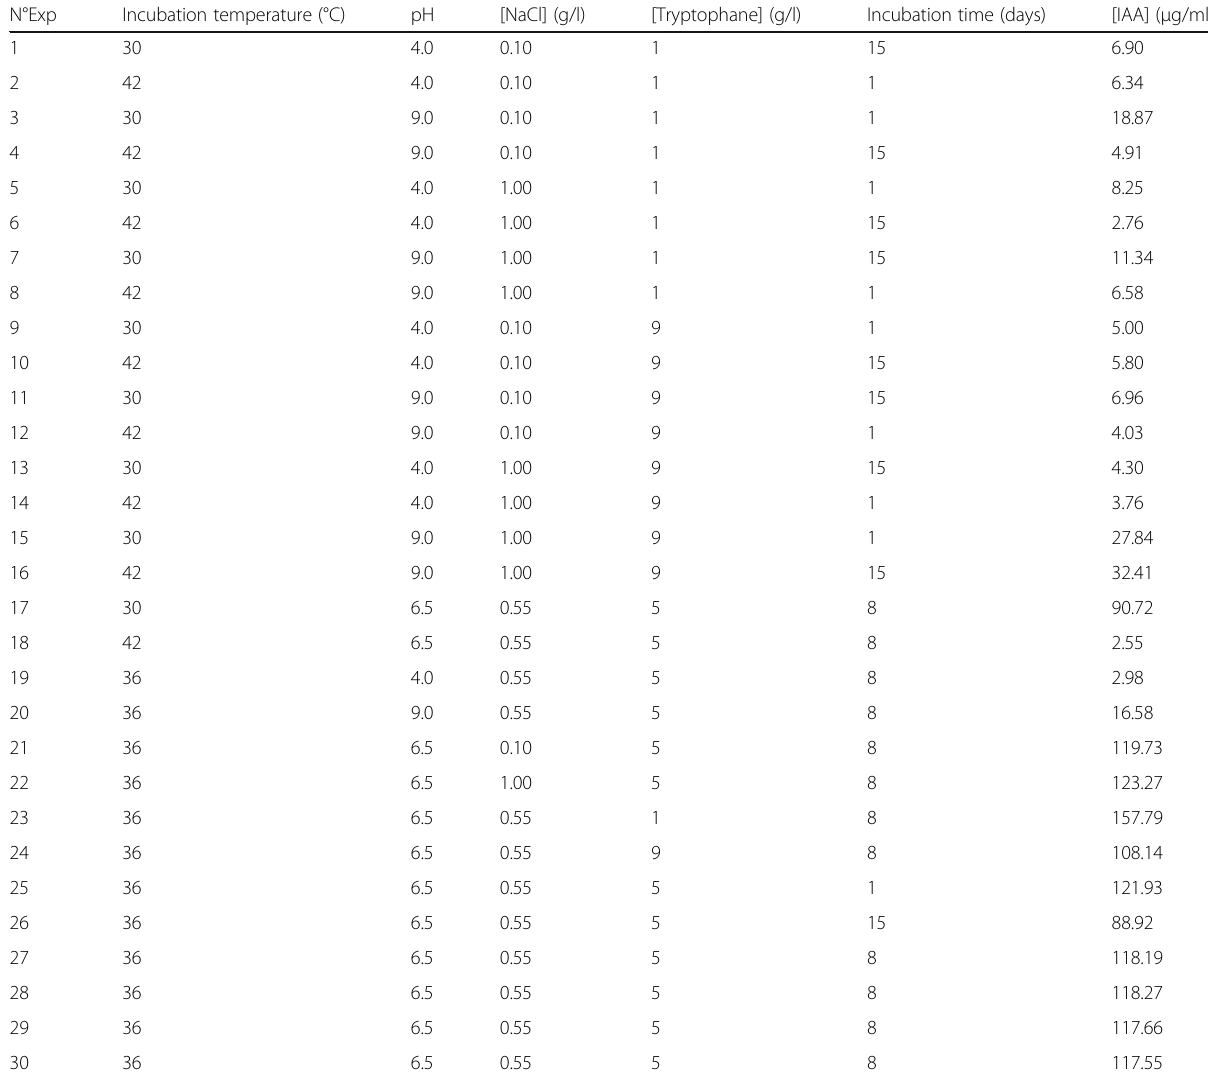
Fig. 2 Inoculation effect by the isolates I22 and I69 on seed germination of Acacia cyanophylla and seedling growth Table 2 Experimental plan for the optimization of IAA production by the strain I69: experiment 27, 28, 29, and 30 represent central